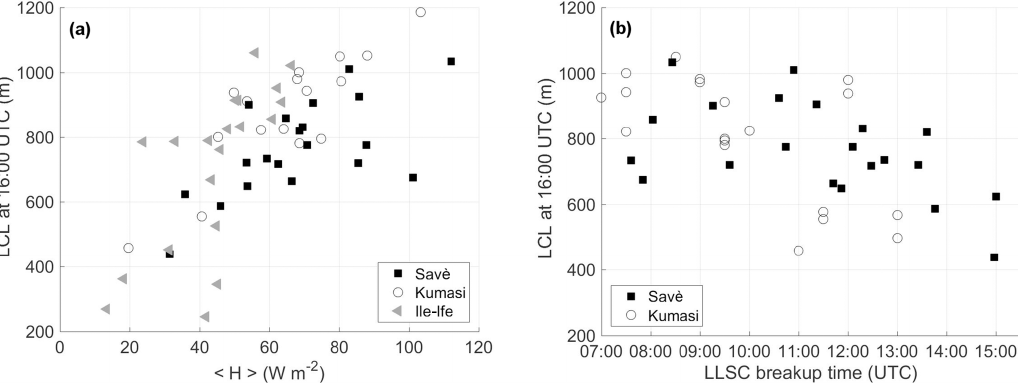
Figure 9. (a) LCL at 1600UTC versus (cid:104) H (cid:105) at the three sites. (b) LCL at 16:00UTC versus LLSC breakup time at Savè and at Kumasi. The LLSC breakup time cannot be estimated at